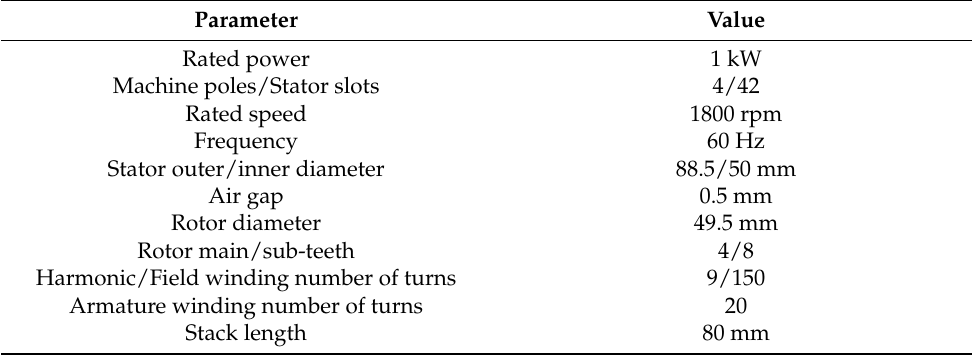
Table 2. Machine